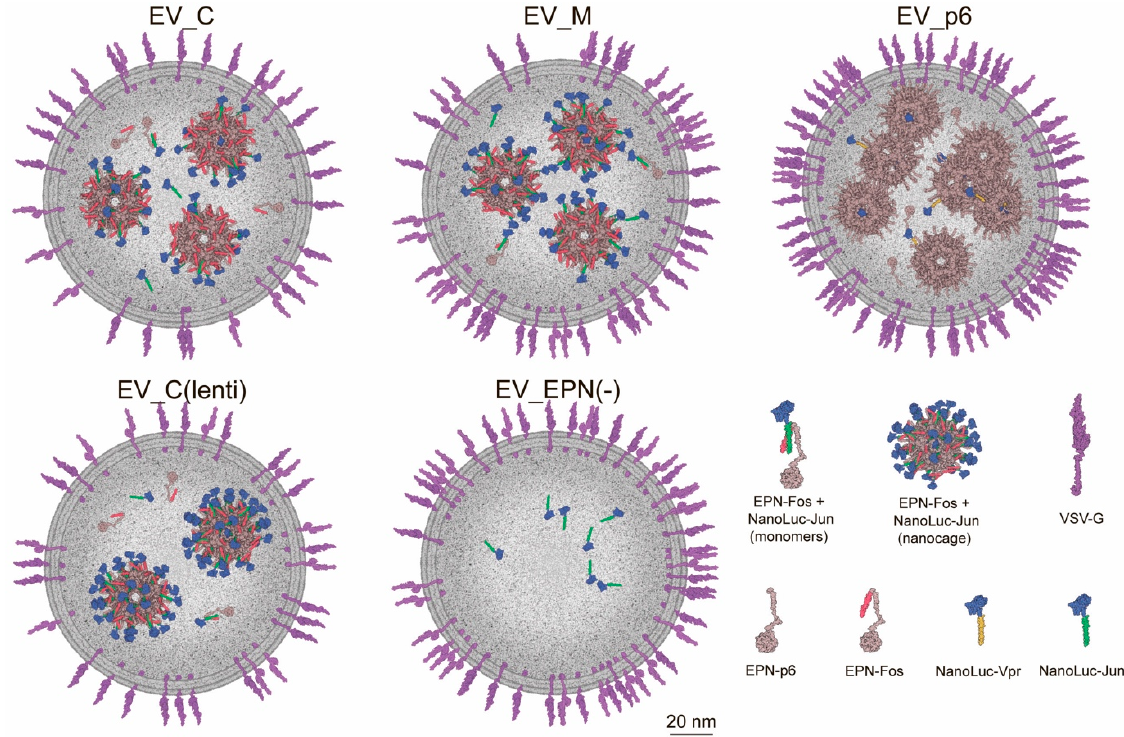
Figure 6. Two-dimensional modeling of EV_C, EV_M, EV_p6, EV_C(lenti) and EV_EPN(-): 1/10 of all proteins of interest